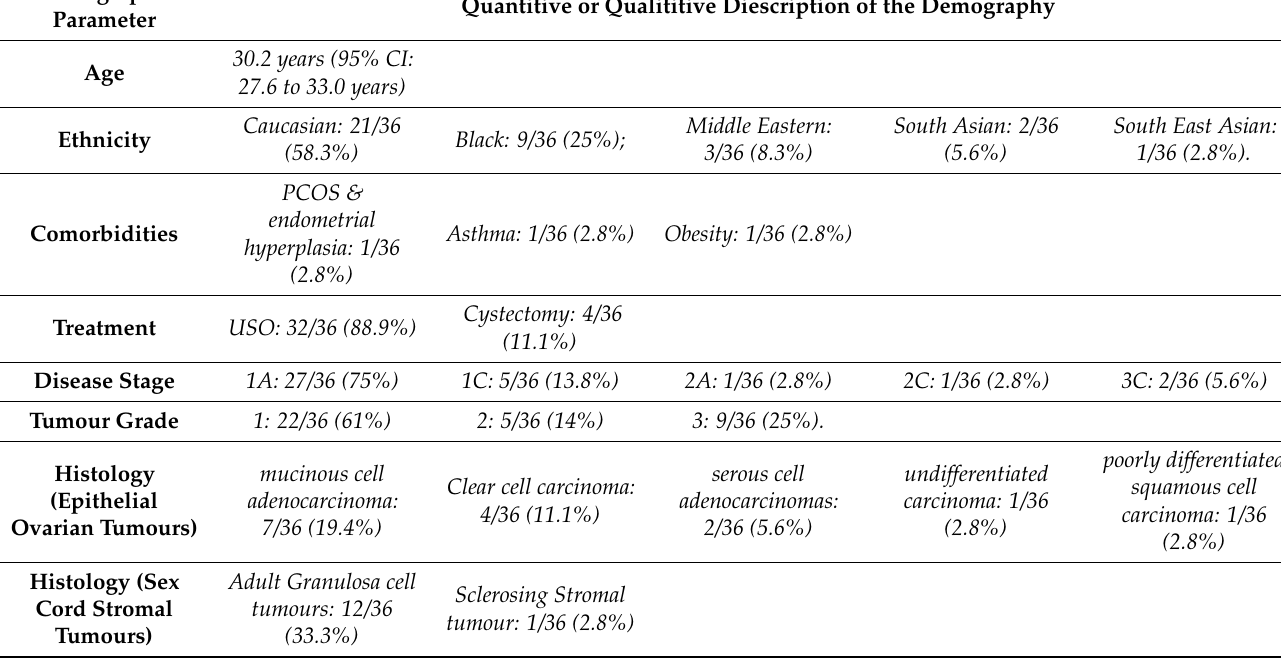
Table 1. Patient and tumour